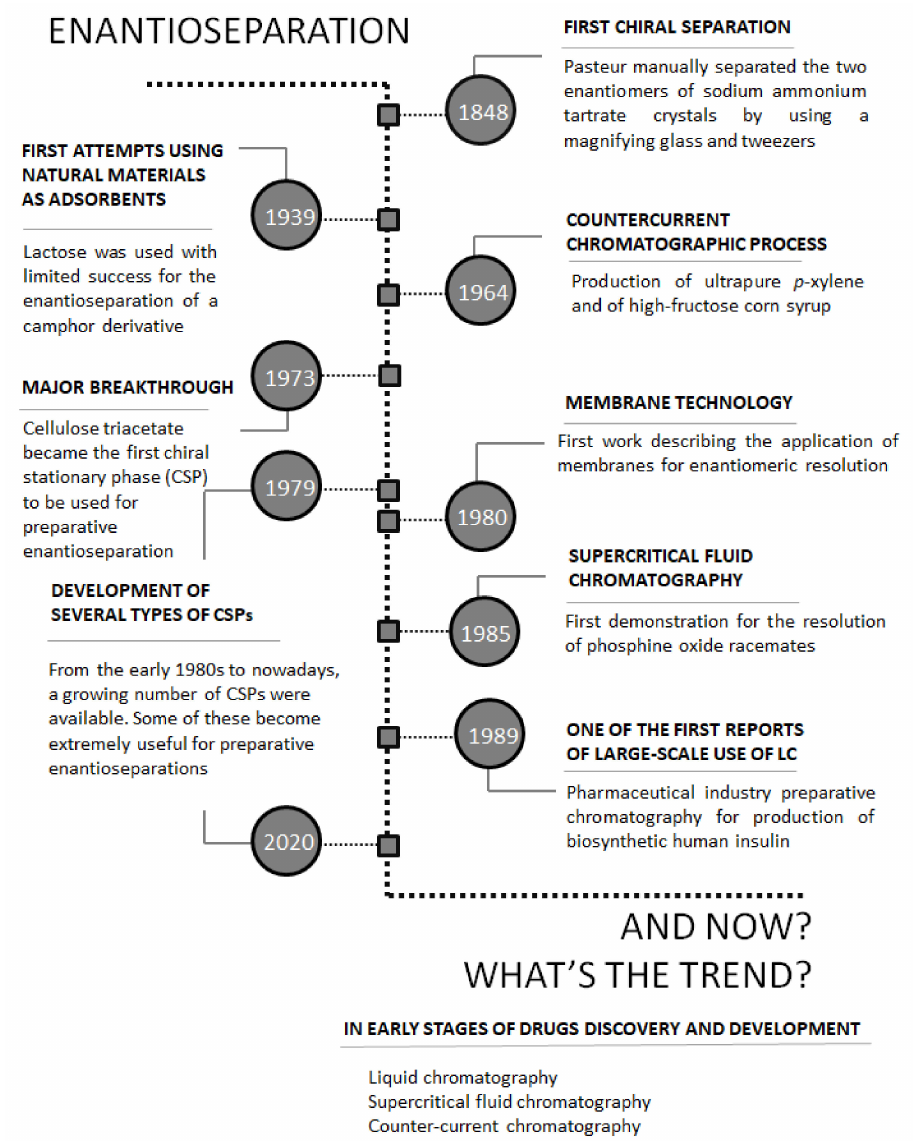
Figure 2. Timeline of the most important landmarks of